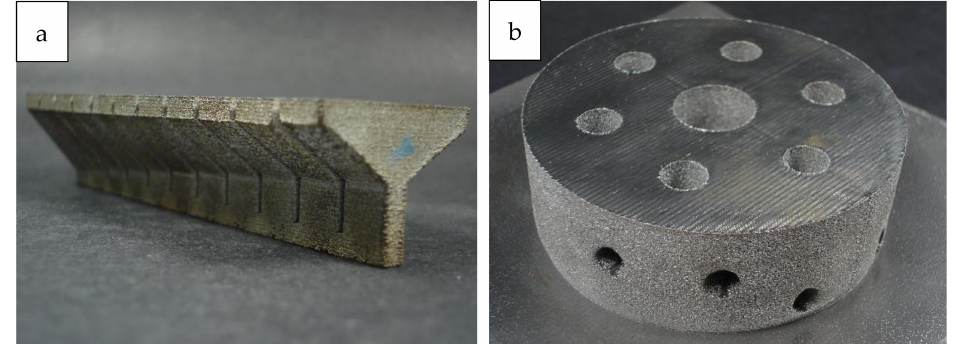
Figure 7. Demonstrator parts. ( a ) 130 mm long test piece manufactured by PBF-EB from X65MoCrWV3-2, demonstrating the ability to fabricate overhangs with angles up to 50 ◦ without support structures. ( b ) Demonstrator part with complex internal channels fabricated by PBF-EB from X37CrMoV5-1. The main diameter is 90